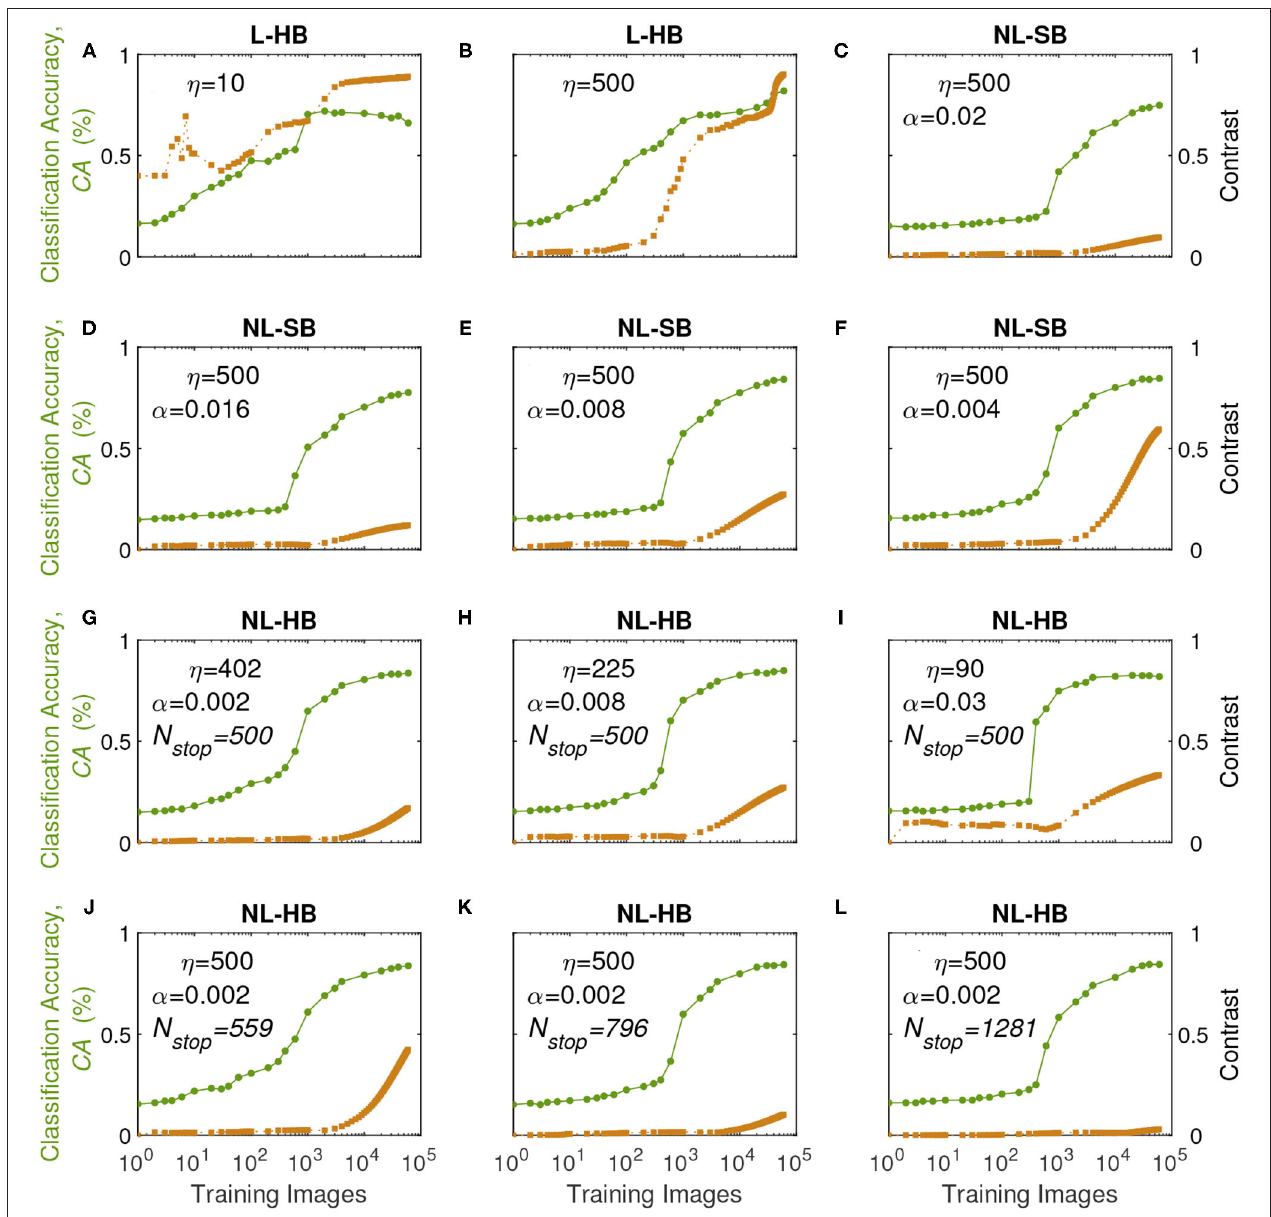
FIGURE 5 | Classification Accuracy ( CA , left axis) and weight contrast (right axis, as defined in the main text) as a function of the number of training images presented to the SNN for various dynamics in the different panels.